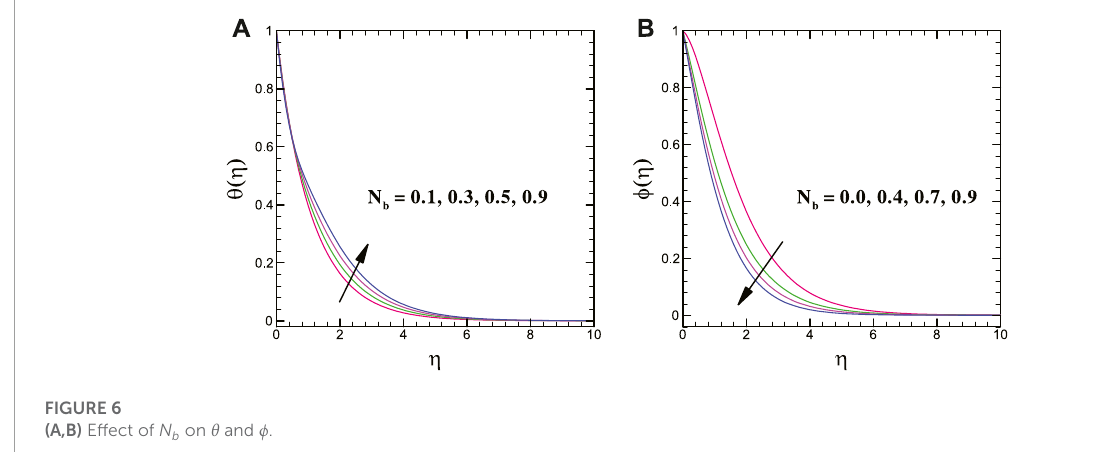
FIGURE 6 (A,B) Effect of N b on θ and ϕ .